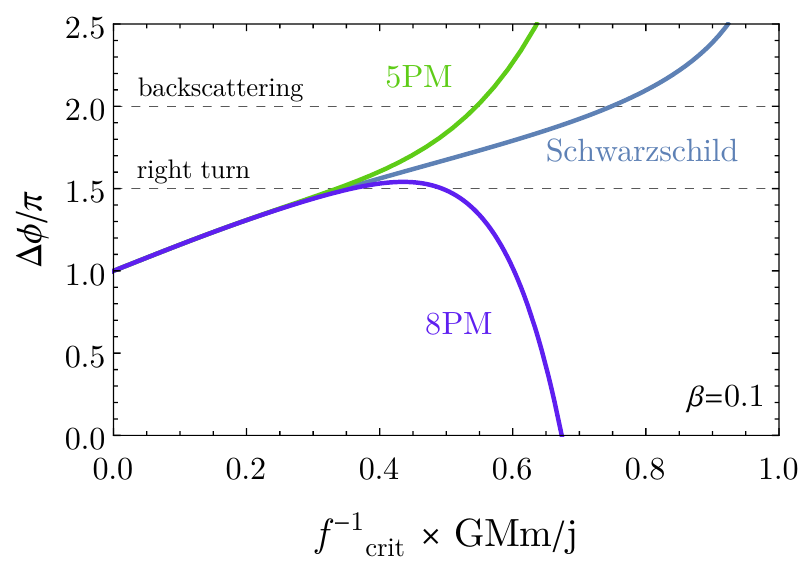
Figure 2 . Classical scattering angle ∆ ϕ vs. f − 1 GMm/j , where f crit is the maximal allowed value crit of GMm/j given by (5.10). The result from eq. (5.8) is shown in blue. Also shown are the 4PM and 8PM expansions of (5.8) in green and purple, respectively. We chose β = 0 . 1 for this plot. Our scattering angle corresponds to trajectories which wind around the origin for GMm/j & 0 . 75 f crit